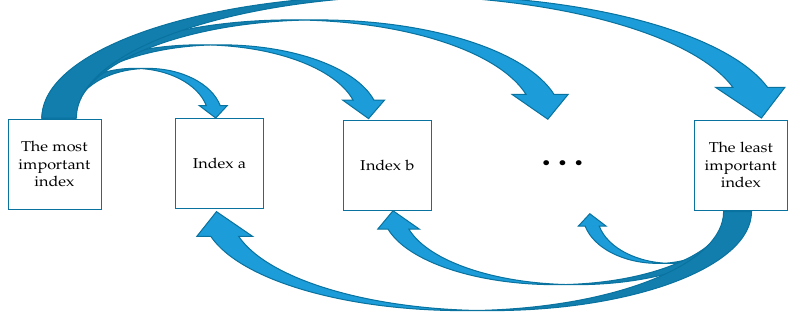
Figure 2. Comparison of importance of index by analytic hierarchy process (AHP) method.